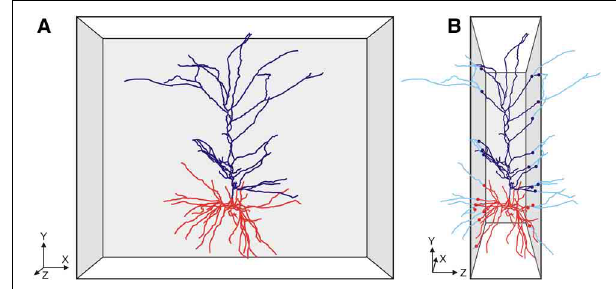
FIGURE 1 | Cartoon of (A) a front view of a slice with a pyramidal neuron extending its apical (dark blue) and basal (red) dendritic branches in the XY direction of the slice, and (B) a side view of the slice with the neuron having many branches cut in the Z-direction of the slice. The cut endings are indicated by colored dots with the lost branches indicated in light blue. Axonal branches are not shown in these cartoon